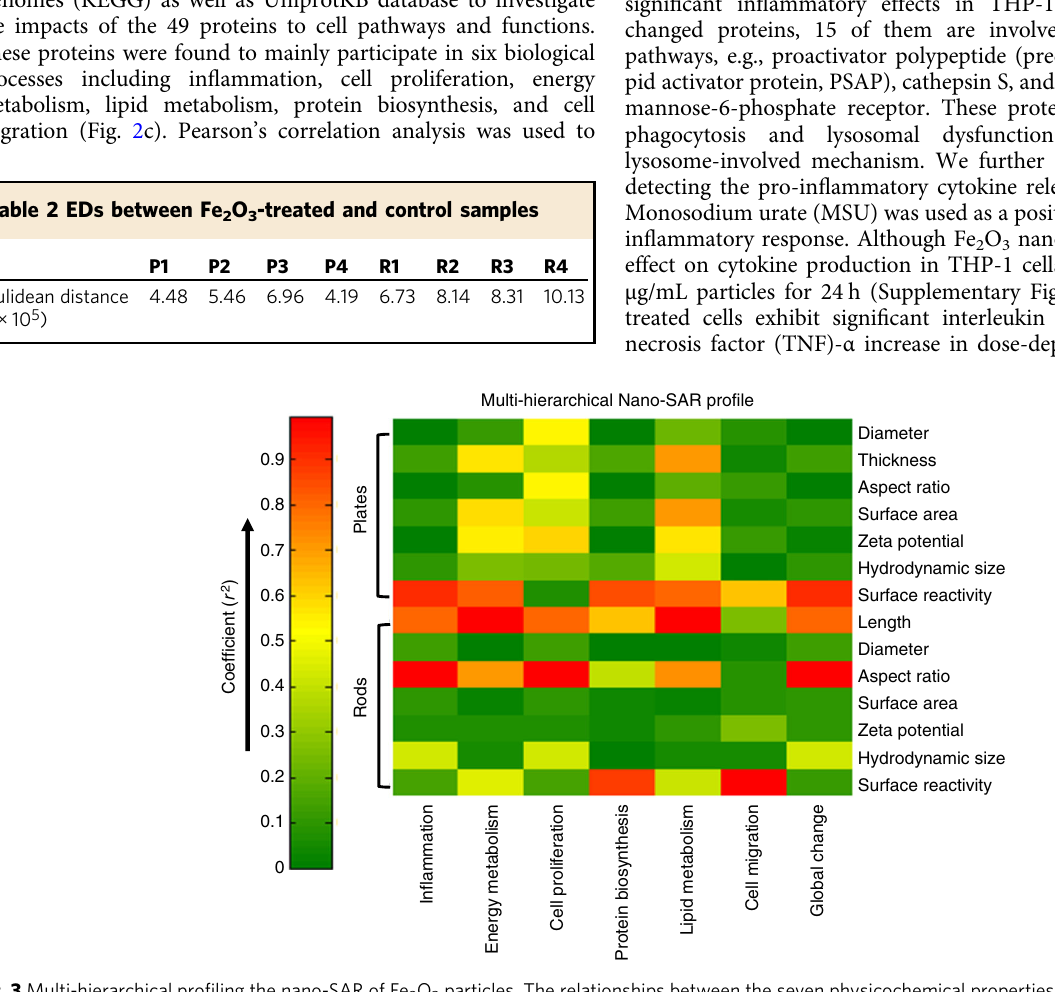
Fig. 3 Multi-hierarchical pro fi ling the nano-SAR of Fe 2 O 3 particles. The relationships between the seven physicochemical properties of Fe 2 O 3 nanoparticles and their bio-effects could be visualized by the heat map, which is established by a regression analysis among differential metabolites, differential proteins, and Fe 2 O 3 properties